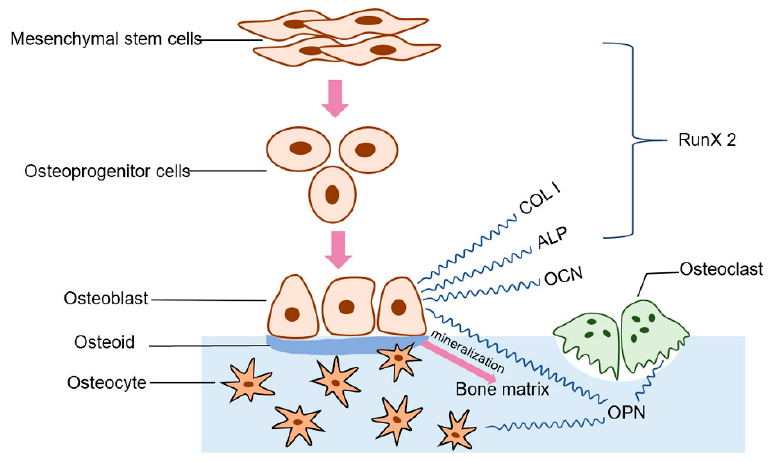
Figure 12. The process of bone formation.